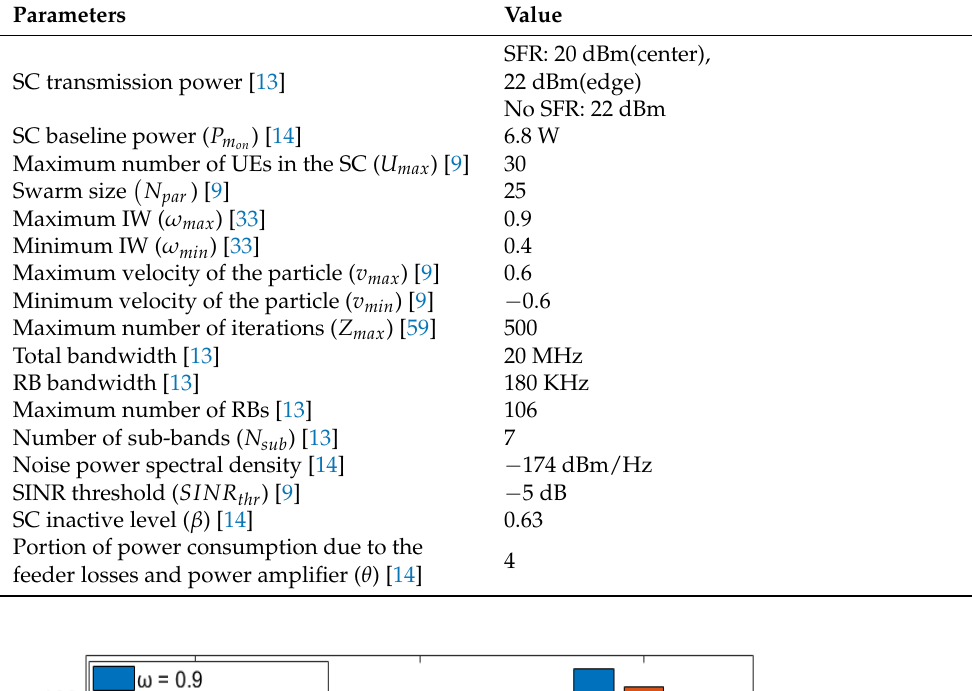
Table 1. Simulation Parameters [9,13,14,33,59].